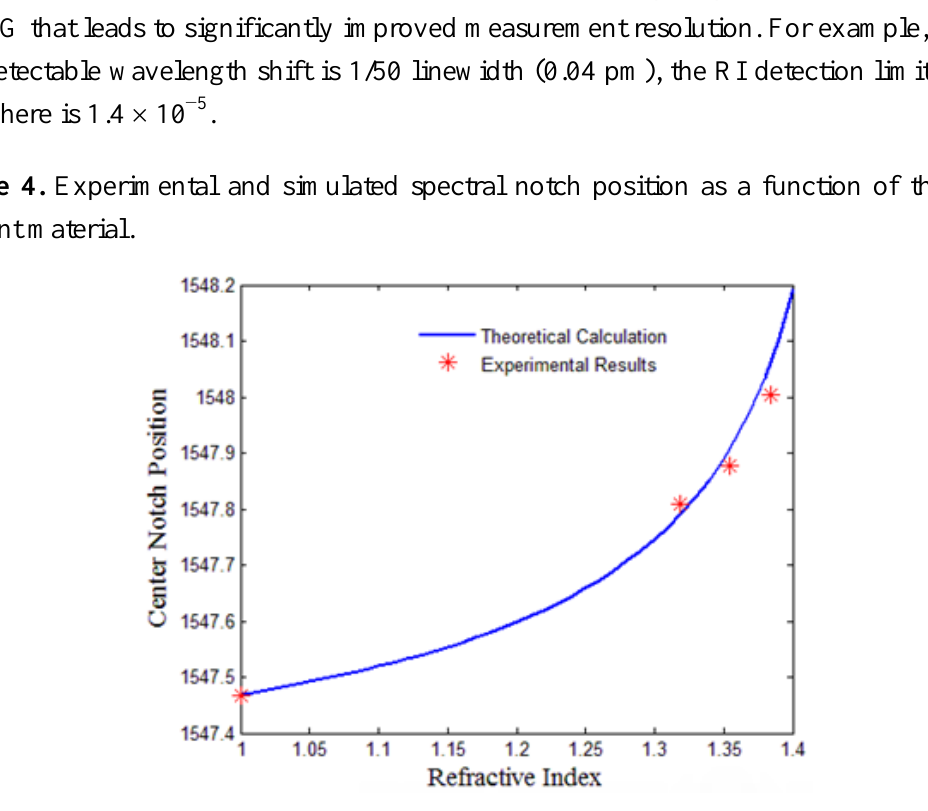
Figure 5. ( a ) Reflection spectra of the πFBG sensor in glycerol-water solutions of